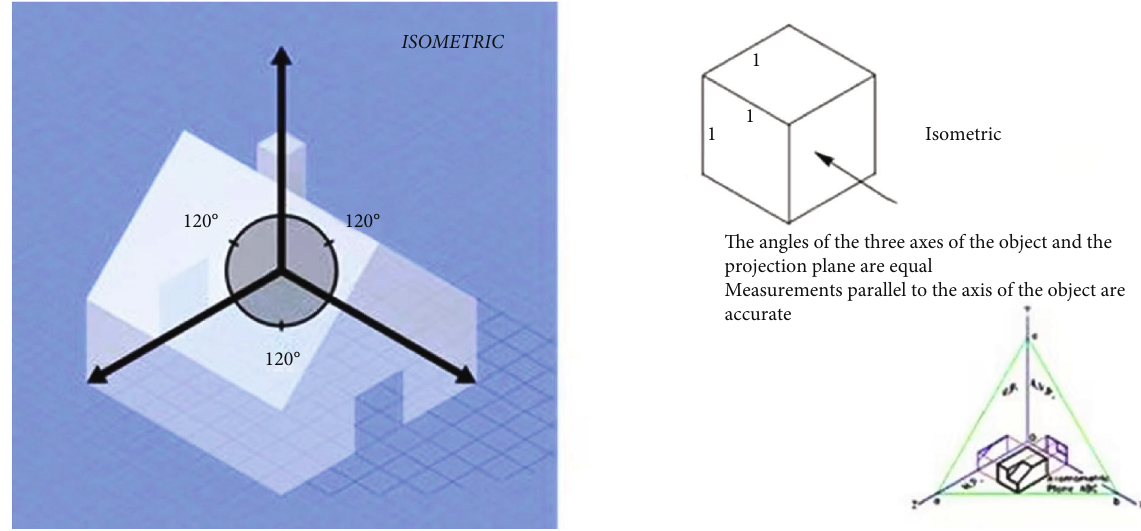
Figure 4: Isometric